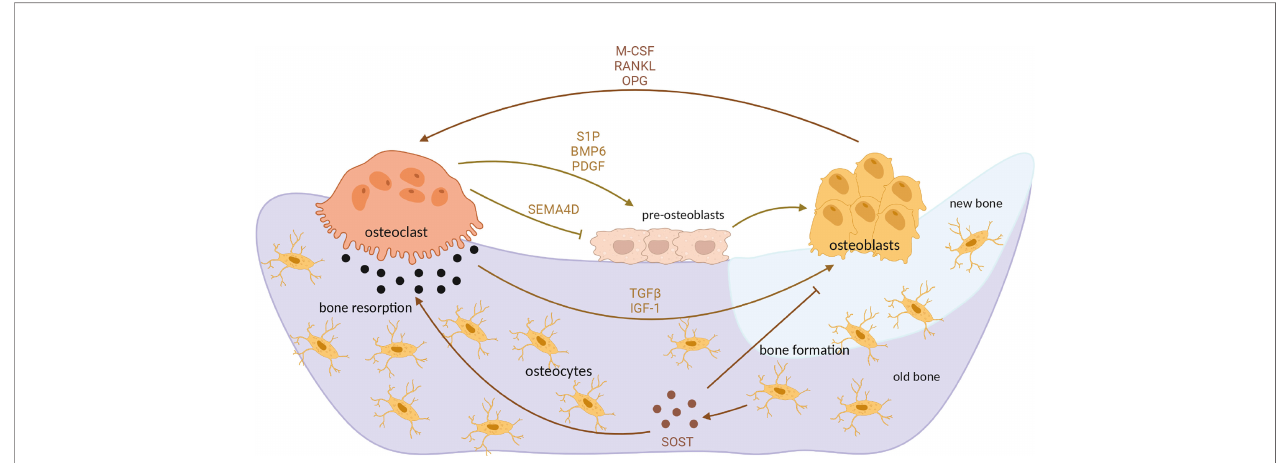
FIGURE 2 | Interaction between osteoblasts and osteoclasts in bone remodeling process. Differentiated, mature osteoclasts secrete acids and matrix metalloproteinases which degrade mineralized bone. Bone resorption mediated by osteoclasts releases TGF b and IGF-1 from bone matrix, which induce osteoblast activity and subsequent bone formation. M-CSF, RANKL and OPG secreted by osteoblasts additionally in fl uence osteoclast differentiation and activity. In turn, osteoclasts secrete various factors which positively (S1P, PDGF) or negatively (SEMA4D) in fl uence osteoblast differentiation. At the end of demineralization process, osteoblast precursors (preosteoblasts) are recruited at the resorption site, differentiating into mature osteoblasts which then form new, unmineralized matrix (osteoid). Upon mineralization, mature osteoblast differentiate into osteocytes which secrete sclerostin, additionally stimulating osteoclastogenesis but inhibiting osteoblast differentiation. OPG, osteoprotegerin; TGF b , transforming growth factor b ; IGF-1, insulin-like growth factor 1; S1P, sphingosine-1-phosphate; PDGF, platelet-derived growth factor; SEMA4D, semaphorin 4D; SOST, sclerostin. Image created by